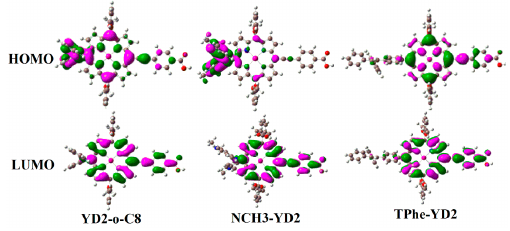
Figure 3. The electron density distributions for the HOMO and LUMO.